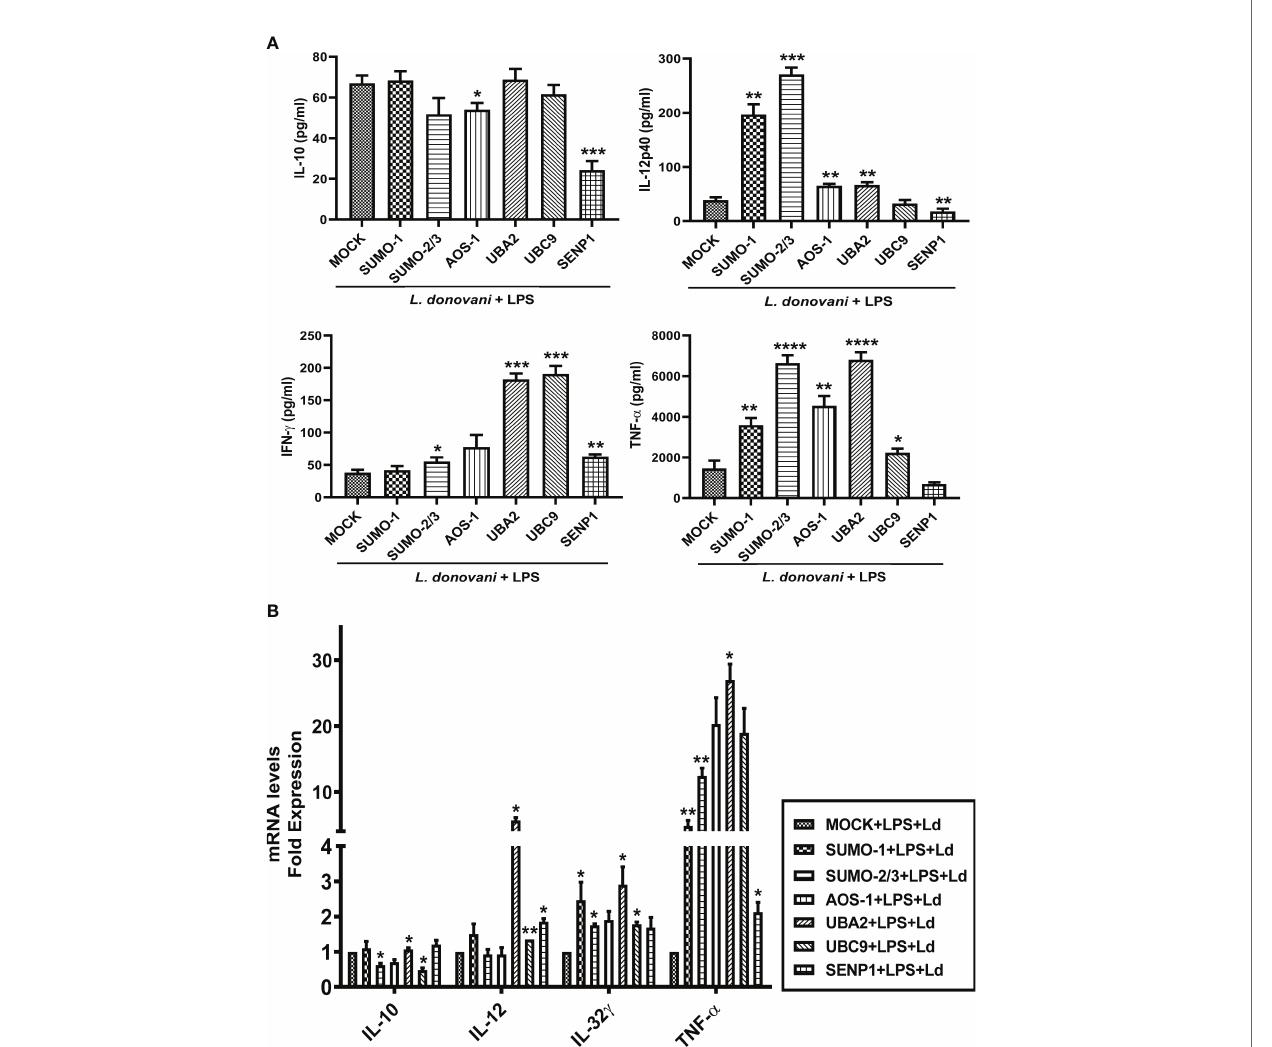
FIGURE 6 | Host SUMOylation promotes the growth of Leishmania donovani by suppressing pro-in fl ammatory cytokines. THP-1 macrophages were transfected with speci fi c siRNAs followed by the infection of L. donovani along with or without the stimulation of LPS (100 ng/ml) for 24 h MOCK here represents the transfection with a control siRNA. Culture supernatants were collected to measure different cytokines, while cells were used to check the expression of in fl ammatory markers at the transcript level. (A) Graph represents cytokine levels measured by sandwich ELISA. Statistical signi fi cance was quanti fi ed using the unpaired t-test with Welch ’ s correction, * p = 0.012 for MOCK vs. AOS-1 and *** p = 0.0003 for MOCK vs. SENP1 for IL-10; ** p = 0.0029, 0.0032, 0.0028, and 0.0074 for MOCK vs. SUMO-1 , AOS-1 , UBA2 , and SENP1 , respectively, and *** p = 0.0002 for MOCK vs. SUMO-2/3 for IL-12p40; * p = 0.025 for MOCK vs. SUMO-2/3 , ** p = 0.002 for MOCK vs. SENP1 , and *** p = 0.0002 and 0.0008 for MOCK vs. UBA2 and UBC9 , respectively, for IFN- g ; * p = 0.049 for MOCK vs. UBC9 , ** p = 0.0012 for MOCK vs. AOS-1 , **** p < 0.0001 for SUMO-2/3 and UBA2 for TNF- a in LPS-stimulated and Ld-infected macrophages. (B) RNA was isolated for gene expression analysis of in fl ammatory cytokines by quantitative real-time PCR (qRT-PCR). * p = 0.04 for MOCK vs. SUMO-2/3 or UBC9 for IL-10 ; * p = 0.04 and 0.05 for MOCK vs. UBA2 and SENP1 , respectively; ** p = 0.008 for MOCK vs. UBC9 for IL-12 ; * p = 0.02 for MOCK vs. SUMO-2/3 and 0.04 for MOCK vs. SUMO-1 or UBA2 or UBC9 for IL-32 g ; * p = 0.05 and 0.02 for MOCK vs. UBA2 and SENP1 , respectively; ** p = 0.01 and 0.008 for MOCK vs . SUMO-1 and SUMO-2/3 for TNF- a in LPS-stimulated and Ld- infected macrophages. p -Value was calculated based on Student ’ s unpaired 2-tailed t-test. LPS,